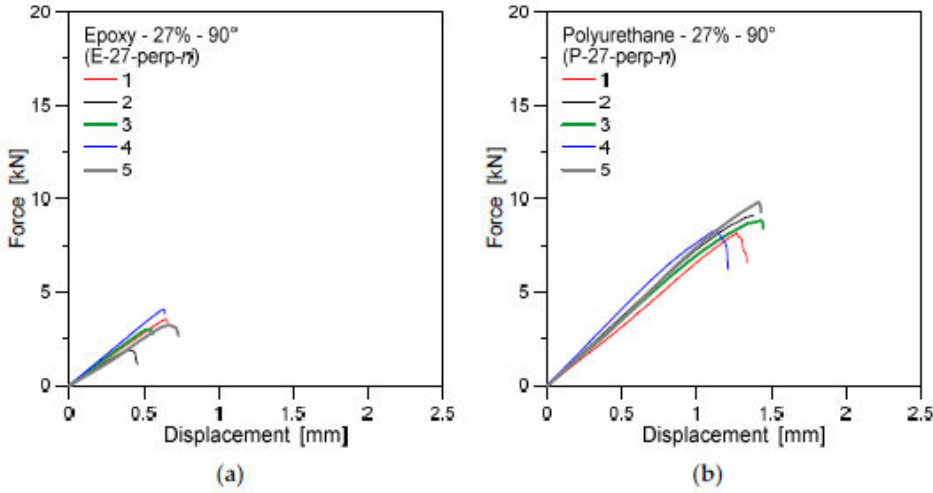
Figure A4. Experimental force–displacement results for specimens with ( a ) epoxy or ( b ) polyurethane glue, under 27% moisture and bonding and perpendicular rod-to-grain